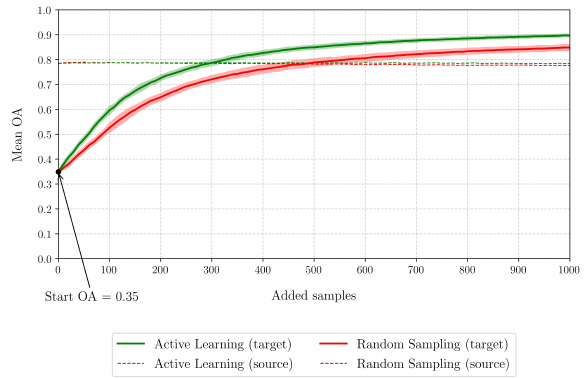
Figure 3. Changes in the average OA scores on the south-western target tile according to the number of added samples with the active learning (green) and random (red) Figure 2. Multi-polarisation color composite of annual means of models. The initial classifier is trained on the north-eastern Sentinel-1 backscatter coefficients (Red: σ 0 , Green: σ 0 , V V V H source Blue: σ 0 ). VH VV